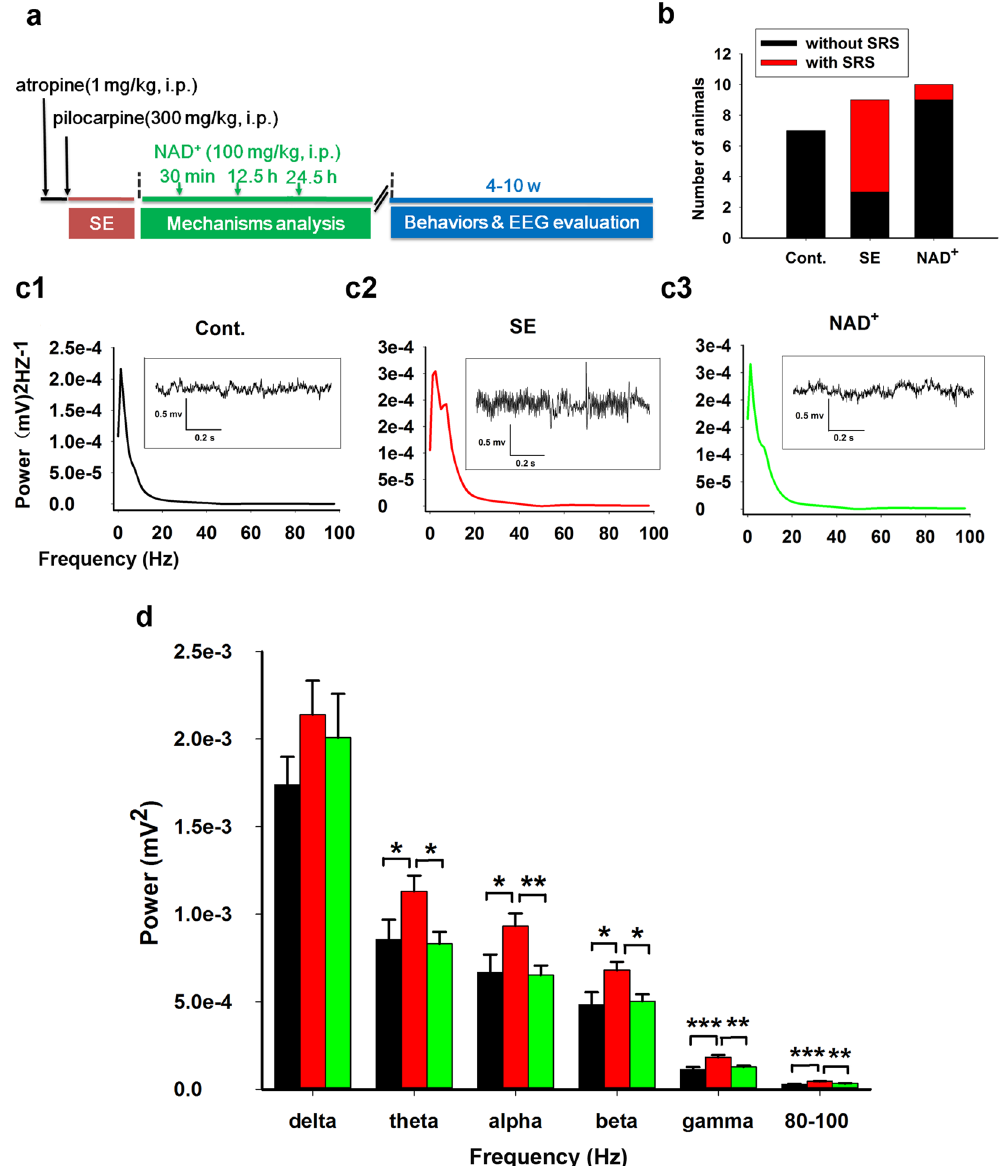
Figure 2. Early-stage intervention with NAD + attenuated the incidence of seizures and abnormal EEG activity in SE model mice at SRS stage. ( a ) Experimental design and timeline. NAD + was i.p. injected three times at 30 min, 12.5 h, and 24.5 h after SE. The incidence of spontaneous seizures and abnormal EEG activity at the SRS stage were evaluated. ( b ) NAD + injection significantly reduced seizure occurrence (Cont., N = 7; SE, N = 9; NAD + , N = 10). The ratio of mice with spontaneous seizures to the total number of mice is shown in the bars. Power spectral values of EEG at 0–100 Hz were analysed. Power spectrum analysis of 12-h EEG from control (c1, N = 9, n = 19), SE (c2, N = 8, n = 28), and NAD + -treated SE group (c3, N = 10, n = 30) was performed. N refers to the number of mice and n indicates the number of days of EEG activity recording. Inset boxes show the representative EEG. ( d ) The statistical results of power values. Black, red, and green bars represent the control, SE model mice, and NAD + -treated SE mice, respectively. * P < 0.05, ** P < 0.01, *** P <